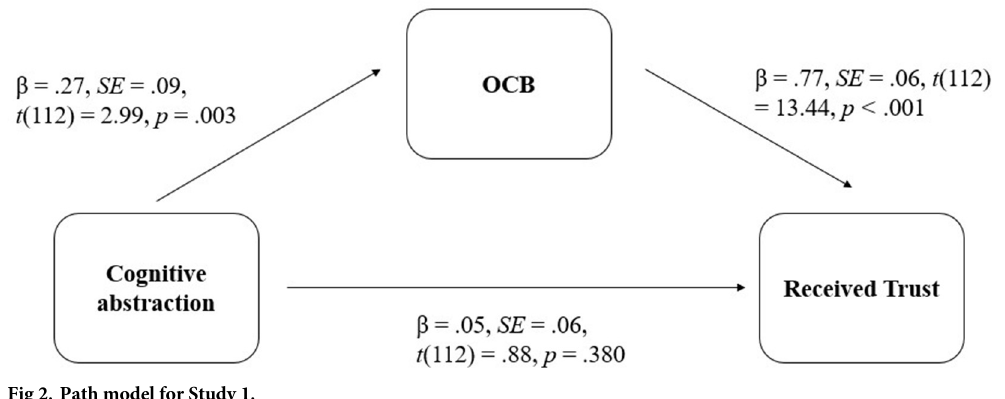
Fig 2. Path model for Study